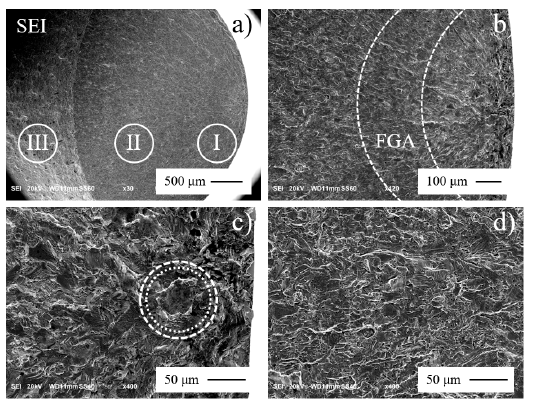
Figure10. SEMmicrographsoffracturesurfaceofagedInconel718( σ a = 600MPa, N f = 1.58 × 10 6 cycles): Figure 10. SEM micrographs of fracture surface of aged Inconel 718 ( σ a = 600 MPa, N f = 1.58 ∗ 10 6 ( a ) fatigue fracture, ( b ) initiation, ( c ) nucleation, ( d ) cycles): ( a ) fatigue fracture, ( b ) initiation, ( c ) nucleation, ( d ) propagation.